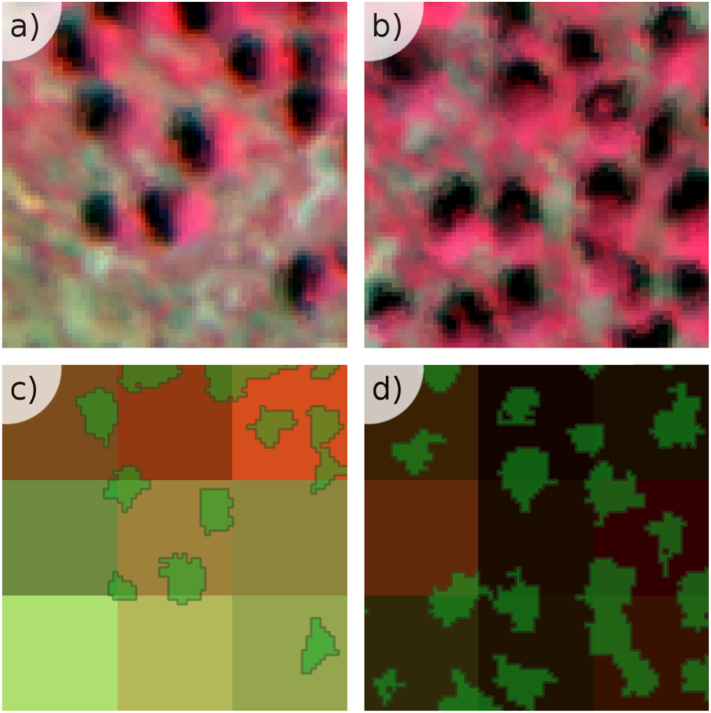
Hyperspectral subsets showing two areas with low (a) and high (b) percentage tree cover. The corresponding Sentinel-2A pixels (c, d) are overlayed on the pure tree crowns obtained through image segmentation.